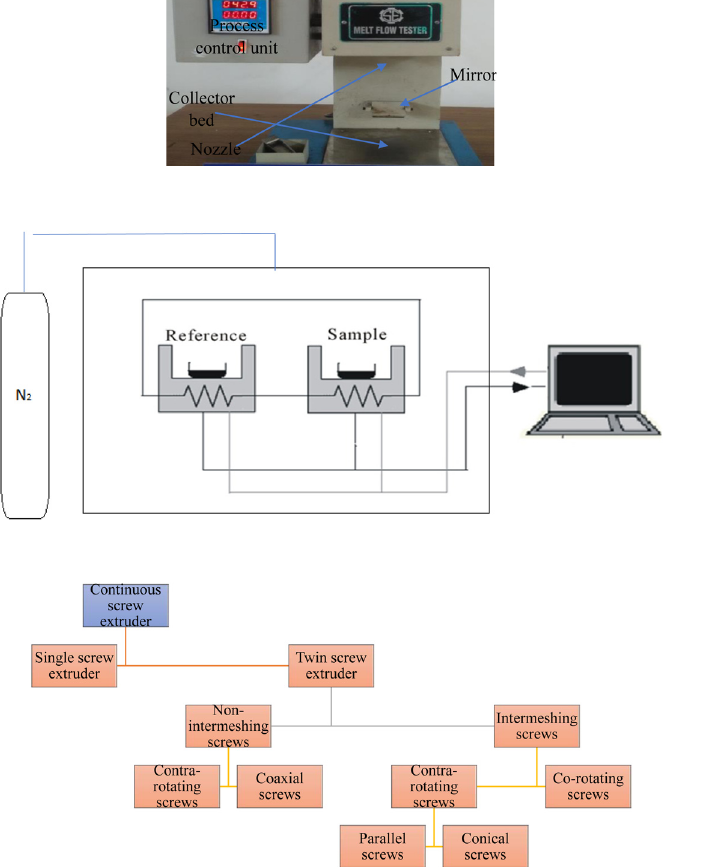
Figure 4. Classi fi cation